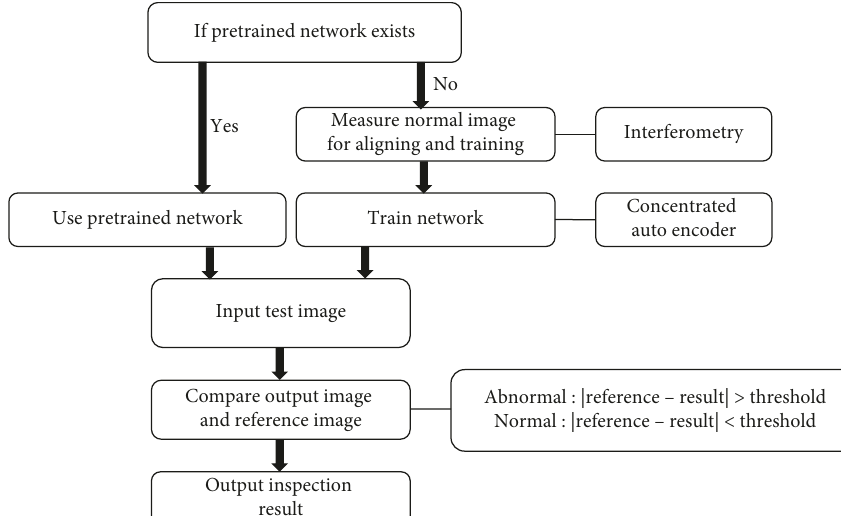
Figure 11: Defect inspection